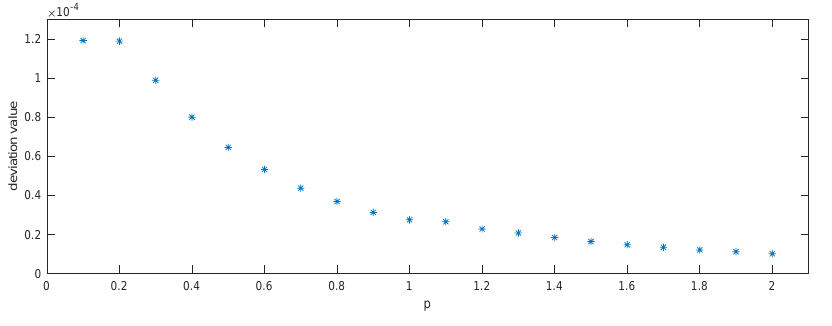
(cid:12) (cid:12) (cid:12) between two formulas with different p (cid:12) ˜ f − f